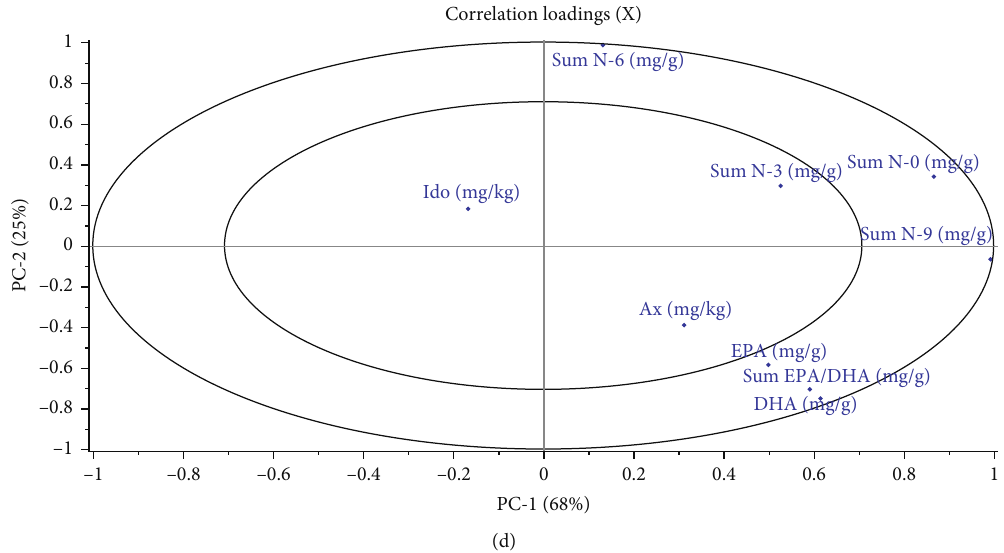
Figure 3: PCA plots Scores (A, C) and correlation loadings (B, D) showing the relationship between the muscle samples and their FA, astaxanthin, and idoxanthin content. Plots A and B show the fi rst principal component (PC-1) compared with the second principal component (PC-2), summarizing 95% of the variation between diet groups from 1.2 kg salmon. Plots C and D show PC-1 compared with PC-2, summarizing 93% of the variation between diet groups from 3.5kg salmon.